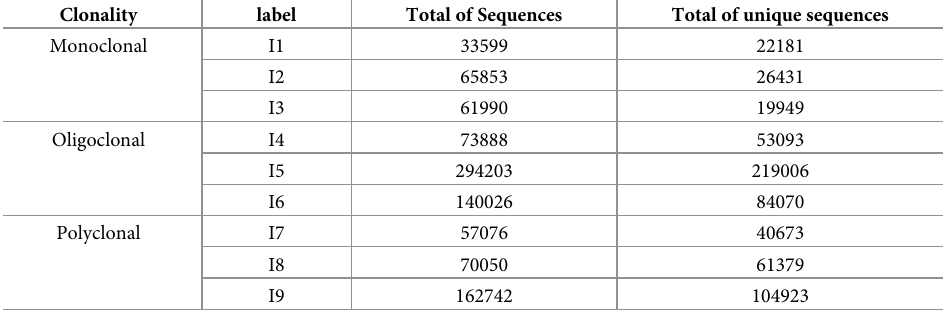
Table 2. Properties of nine experimental repertoires. For each sample, we show clonality status, the individual label, the total number of sequences and unique sequences (clonotypes).